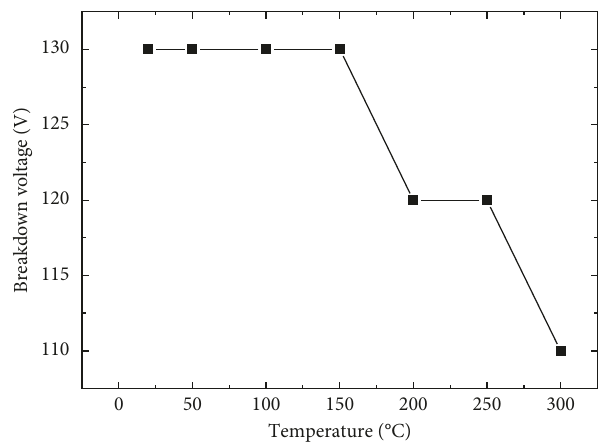
Figure 11: The temperature dependence of the reverse breakdown voltage of diodes based on 4 H -SiC out at a current of